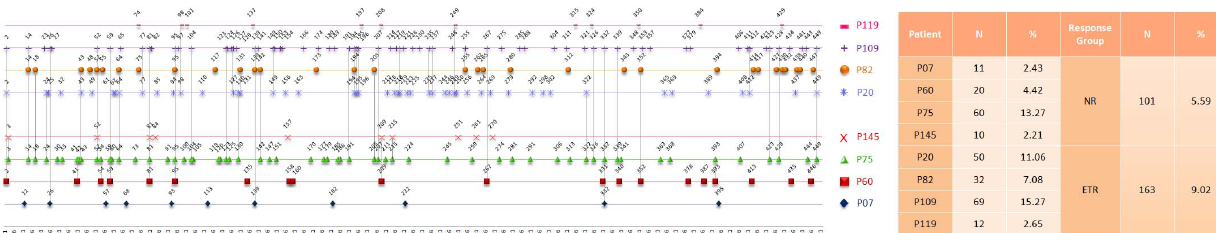
Figure 5. Negative selection. Sites under negative selection for each patient. Measured by v rates considering p , 0.1. Vertical lines link sites negatively selected in more than one patient.